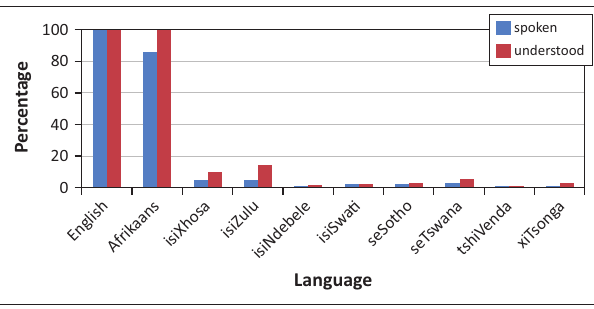
FIGURE 1: A bar chart showing the language competence percentages of SLTs in SA (Data to be interpreted with caution due to low response